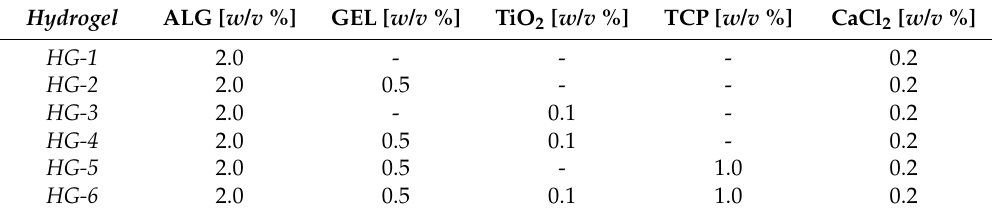
Table 1. Summary of the compositions of the hydrogels in weight/volume